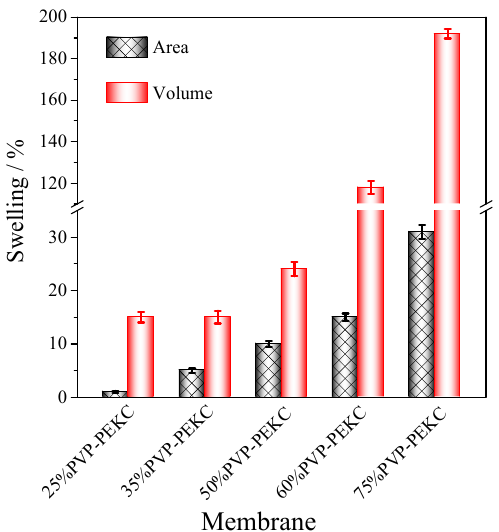
Figure 5. Dimensional swellings of various x%PVP-PEKC blend membranes at RT.